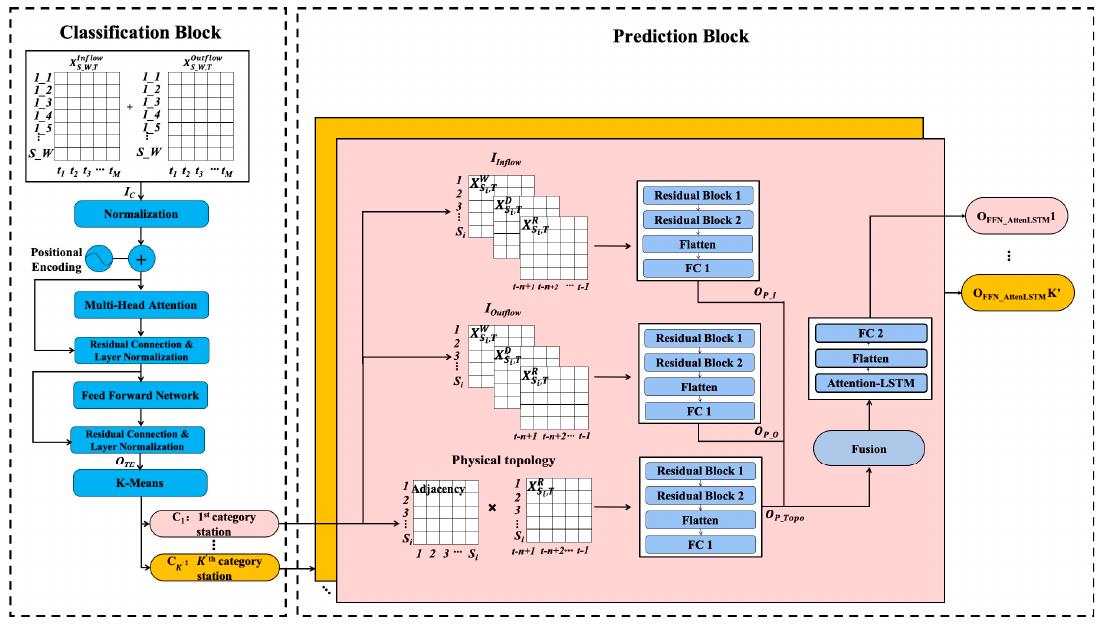
Figure 2, it consists of two blocks: the classification block and the prediction block. The classification block extracts the deep features from the inflow and outflow data based on the Transformer encoder, then classifies the stations based on K-Means. A prediction block is used to predict the inflow for each type of station, and then integrate them as the final result for all stations in the whole network.